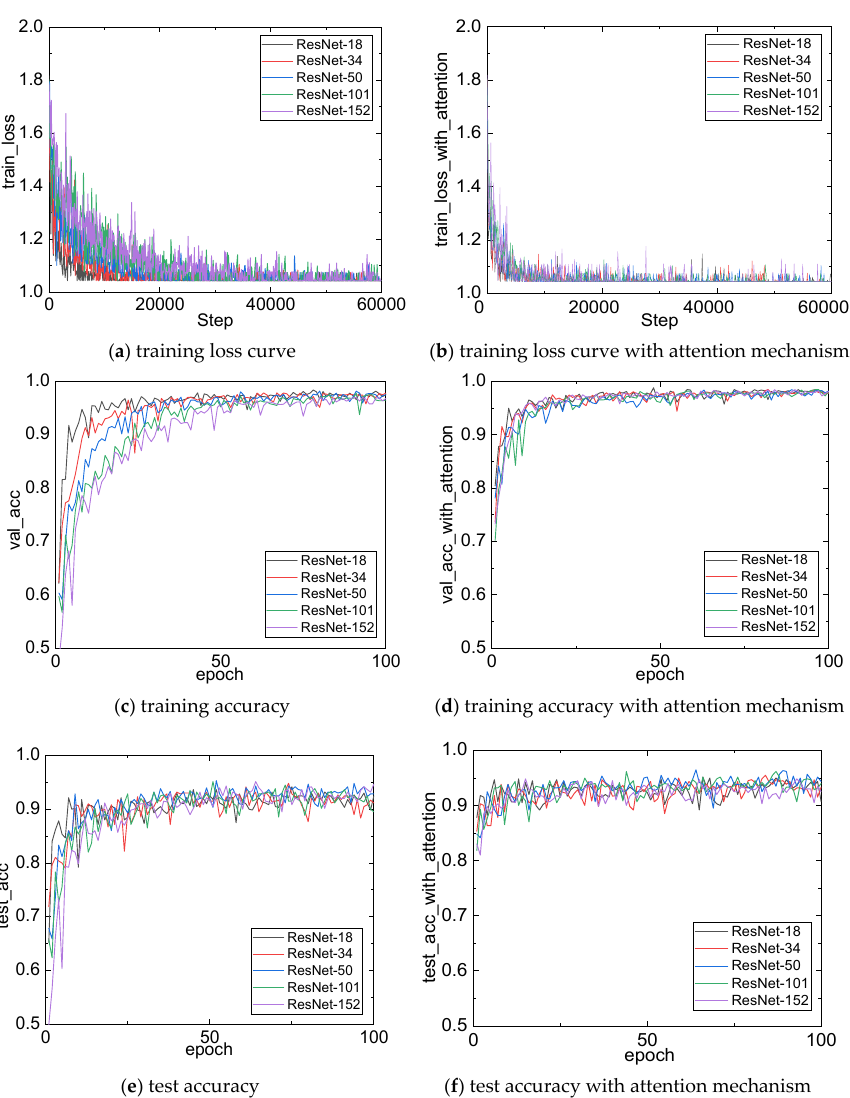
Figure 4. Comparison diagrams of the training results.